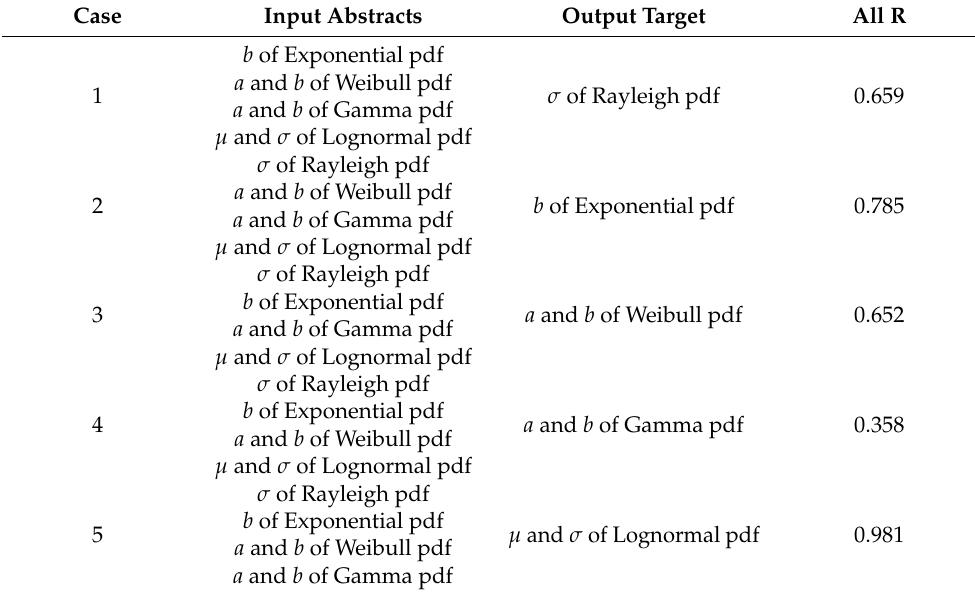
Table 2. Performances of NN case